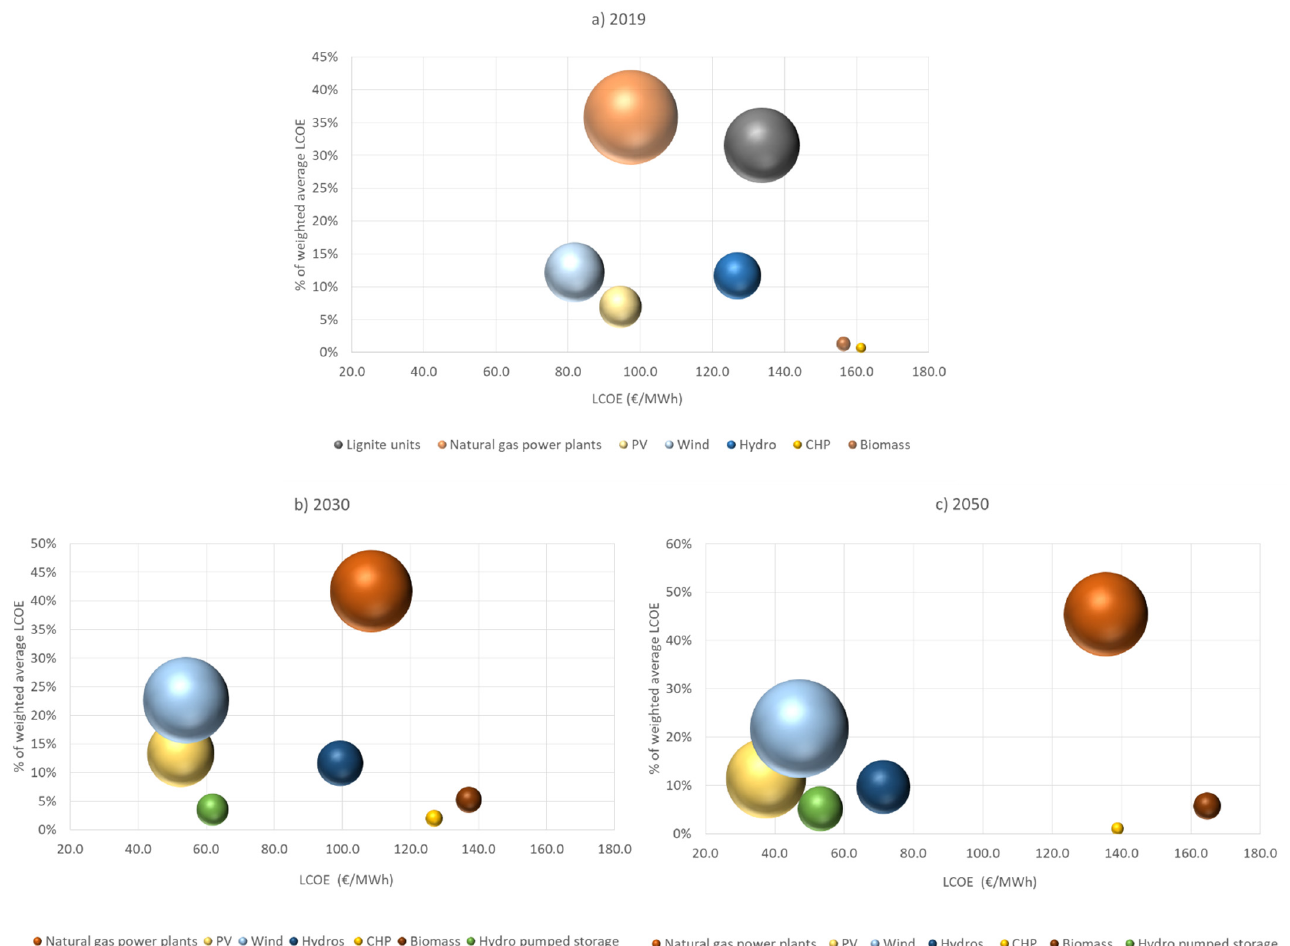
Figure 7. Levelized Cost of Energy and contribution to the weighted average cost of the system by technology (the size of the bubbles corresponds to power generation by each type of technology).